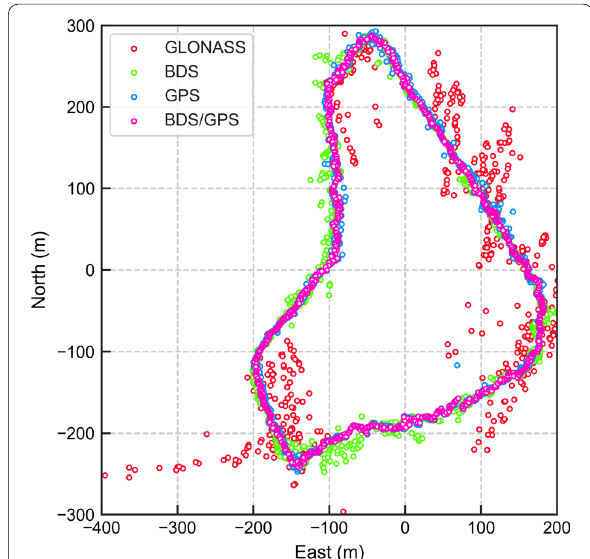
Fig. 19 Kinematic smartphone positioning results based on different satellite systems